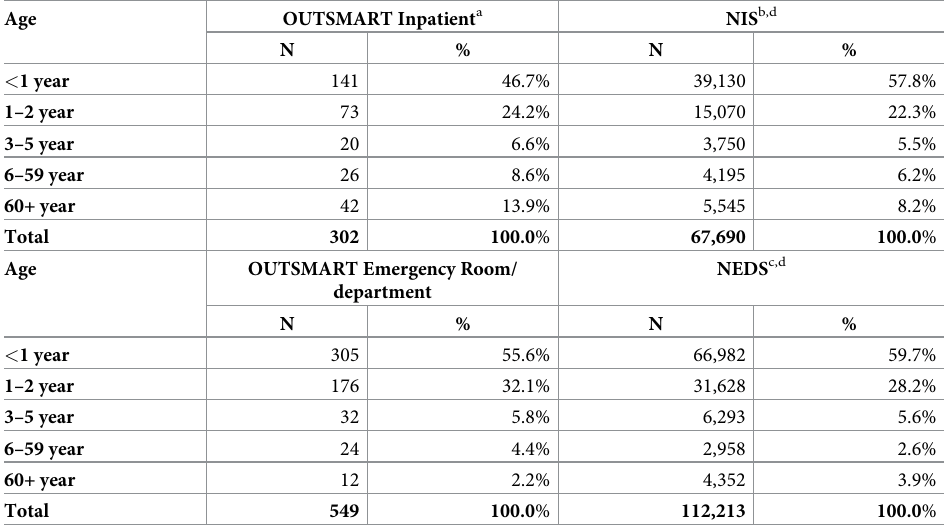
Table 2. OUTSMART November 2016—March 2017 RSV positive inpatient and Emergency Room cases com- pared with NIS and NEDS RSV positive cases during November 2013-March 2014 by age group.